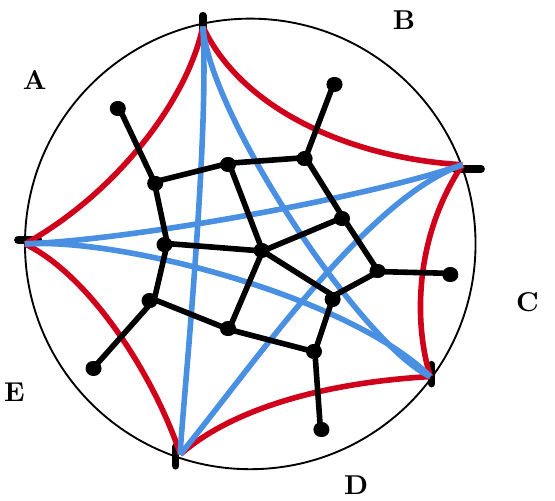
Figure 3 . A minimal graph with one vertex for every intersection of RT regions. (For a non-planar graph there will in general be many more non-empty intersections, not shown